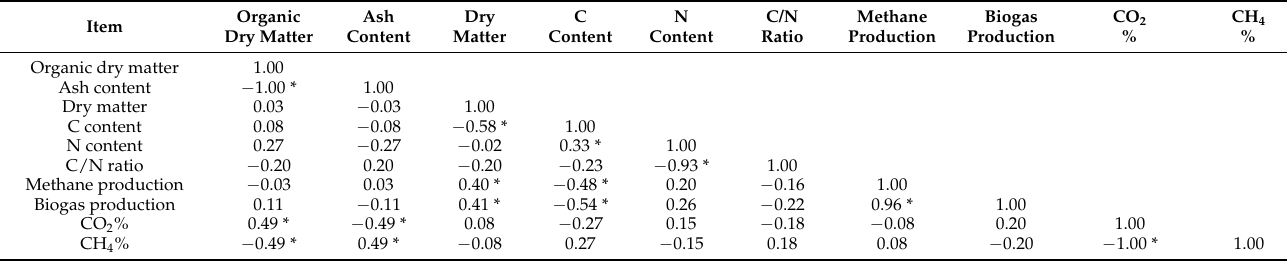
Table 5. The Pearson correlation coefficients for the analyzed